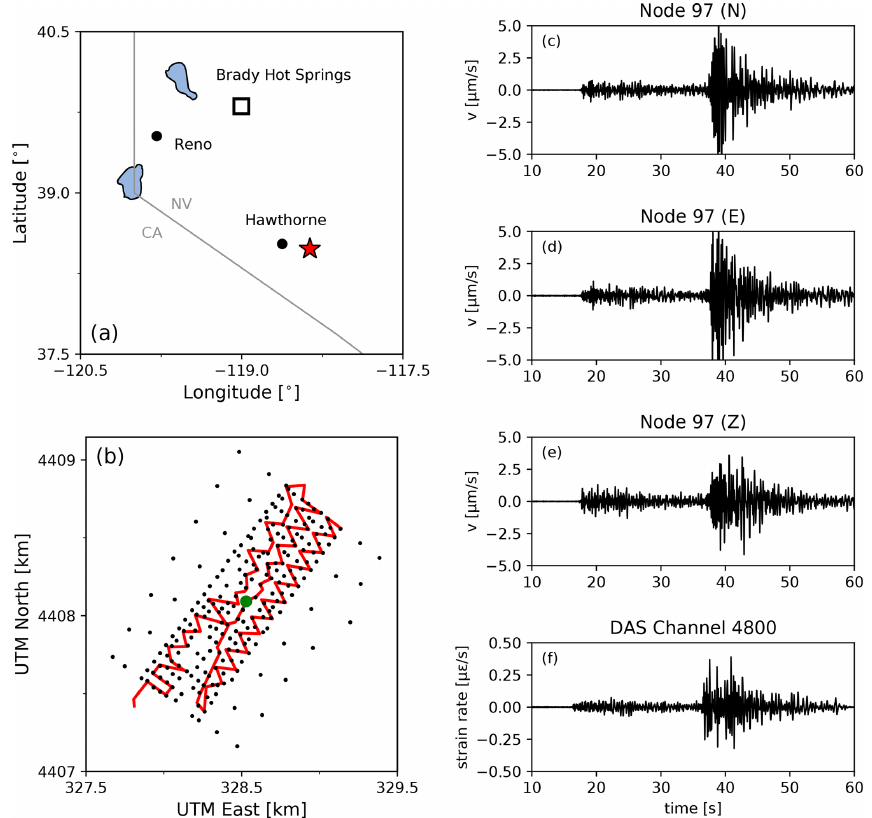
Figure 1. (a) Location of the Brady Hot Springs natural laboratory and the March 2016 M L 4.3 Hawthorne earthquake epicentre; (b) layout of the PoroTomo nodal seismometer array (black dots) and the fibre-optic cable (red line); (c–e) ground motions recorded on the N/E/Z com- ponents of nodal seismometer no. 97, which is marked in panel (b) by a green dot; (f) strain rates recorded by a channel co-located with nodal seismometer no. 97. All waveforms are filtered in a 0.5–10Hz pass